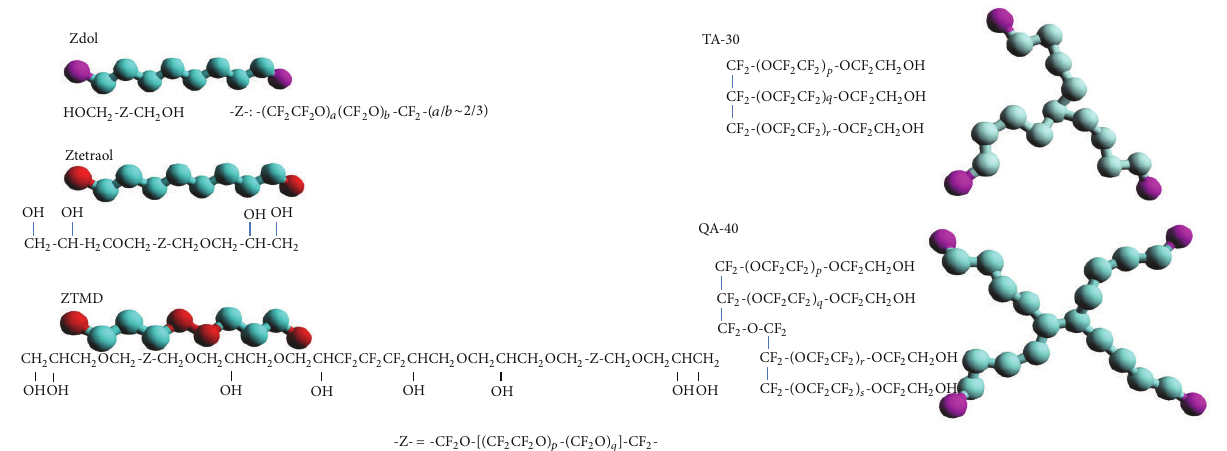
Figure 30: Coarse-grained bead-spring models of linear PFPEs (Z-dol, Z-tetraol, and ZTMD) and star-like PFPEs with three and four arms (TA-30 and QA-40), where magenta and red beads represent hydrogenated functional groups.